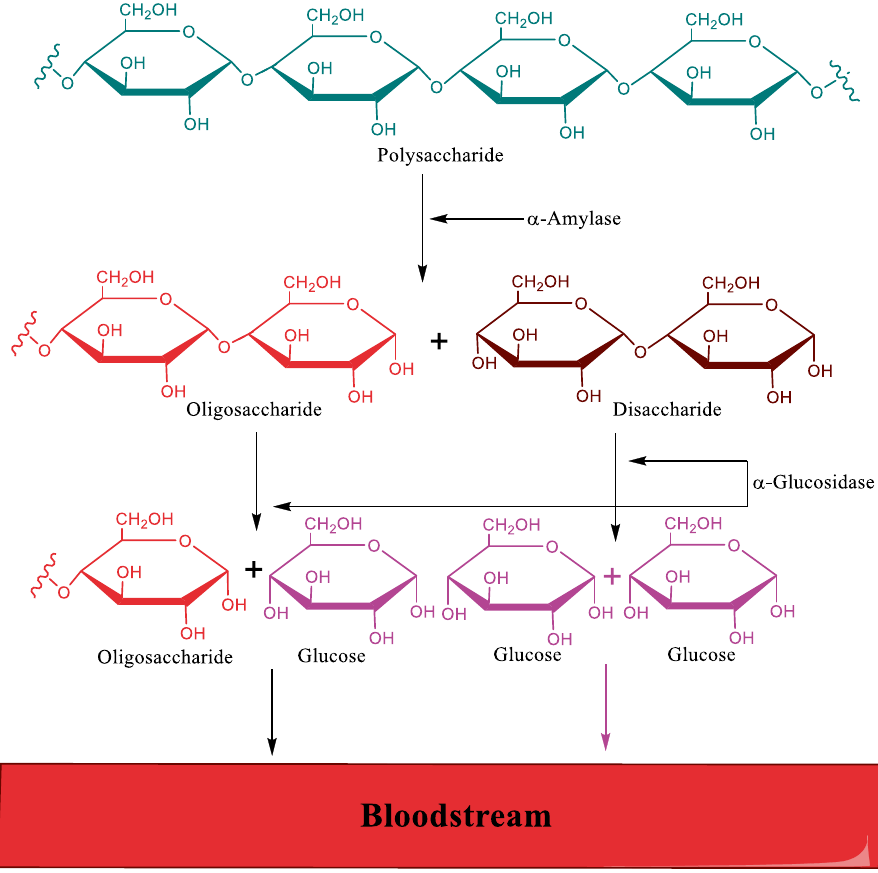
Figure 1. Schematic diagram illustrating the mechanism of action of α-amylase and α-glucosidase (ChemDraw